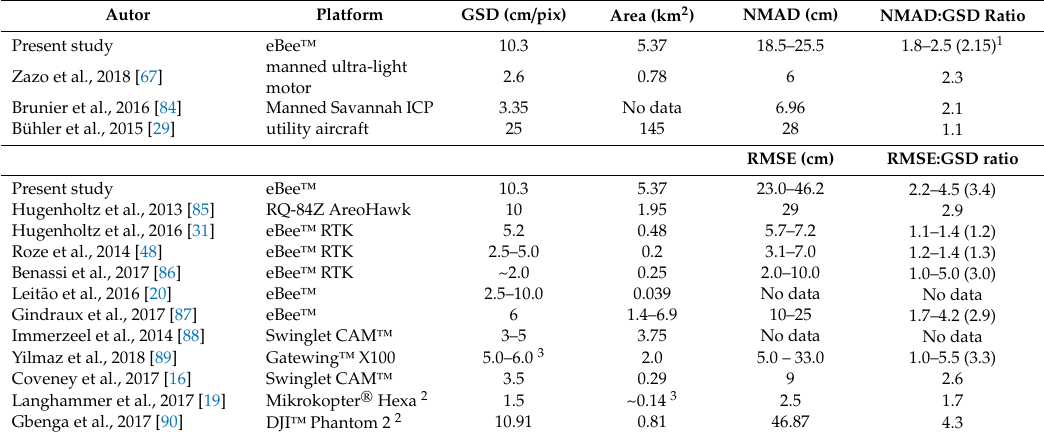
Table A2. Related studies of DSM and DEM accuracy reported (absolute and